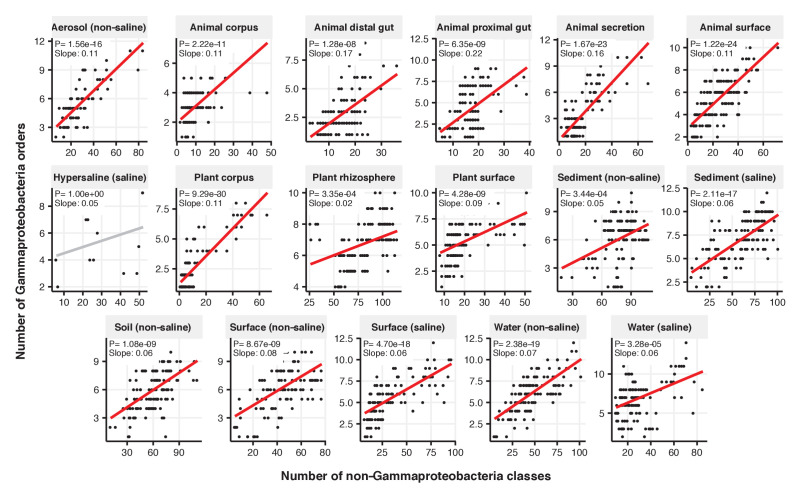
Focal-lineage diversity as a function of community diversity across biomes in Gammaproteobacteria.Linear models are shown for the number of orders per class (y-axis) as a function of community diversity (non-focal classes, x-axis) in each of the 17 environments (EMPO3 biomes). Only environments containing the focal lineage are shown. Significant positive diversity slopes are shown in red (linear models, p<0.05, Bonferroni corrected for 17 tests), and non-significant in grey.